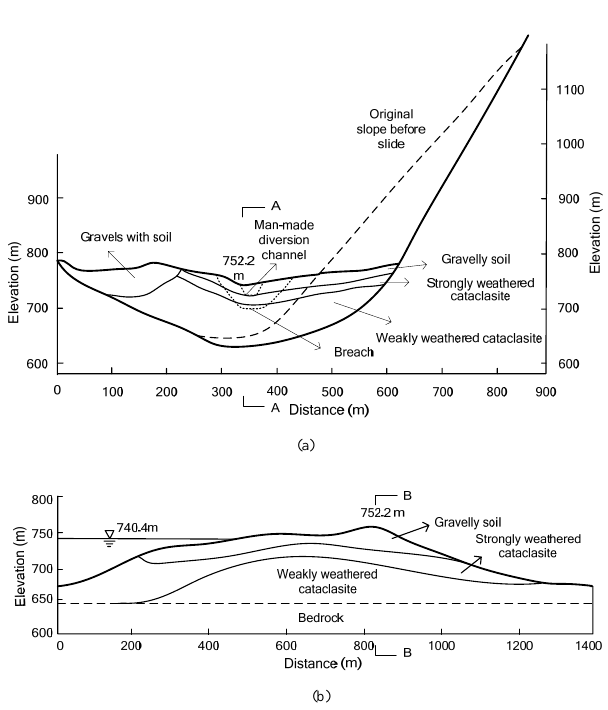
Fig. 3. Cross sections of Tangjiashan Landslide Dam: (a) across the river; (b) along the river